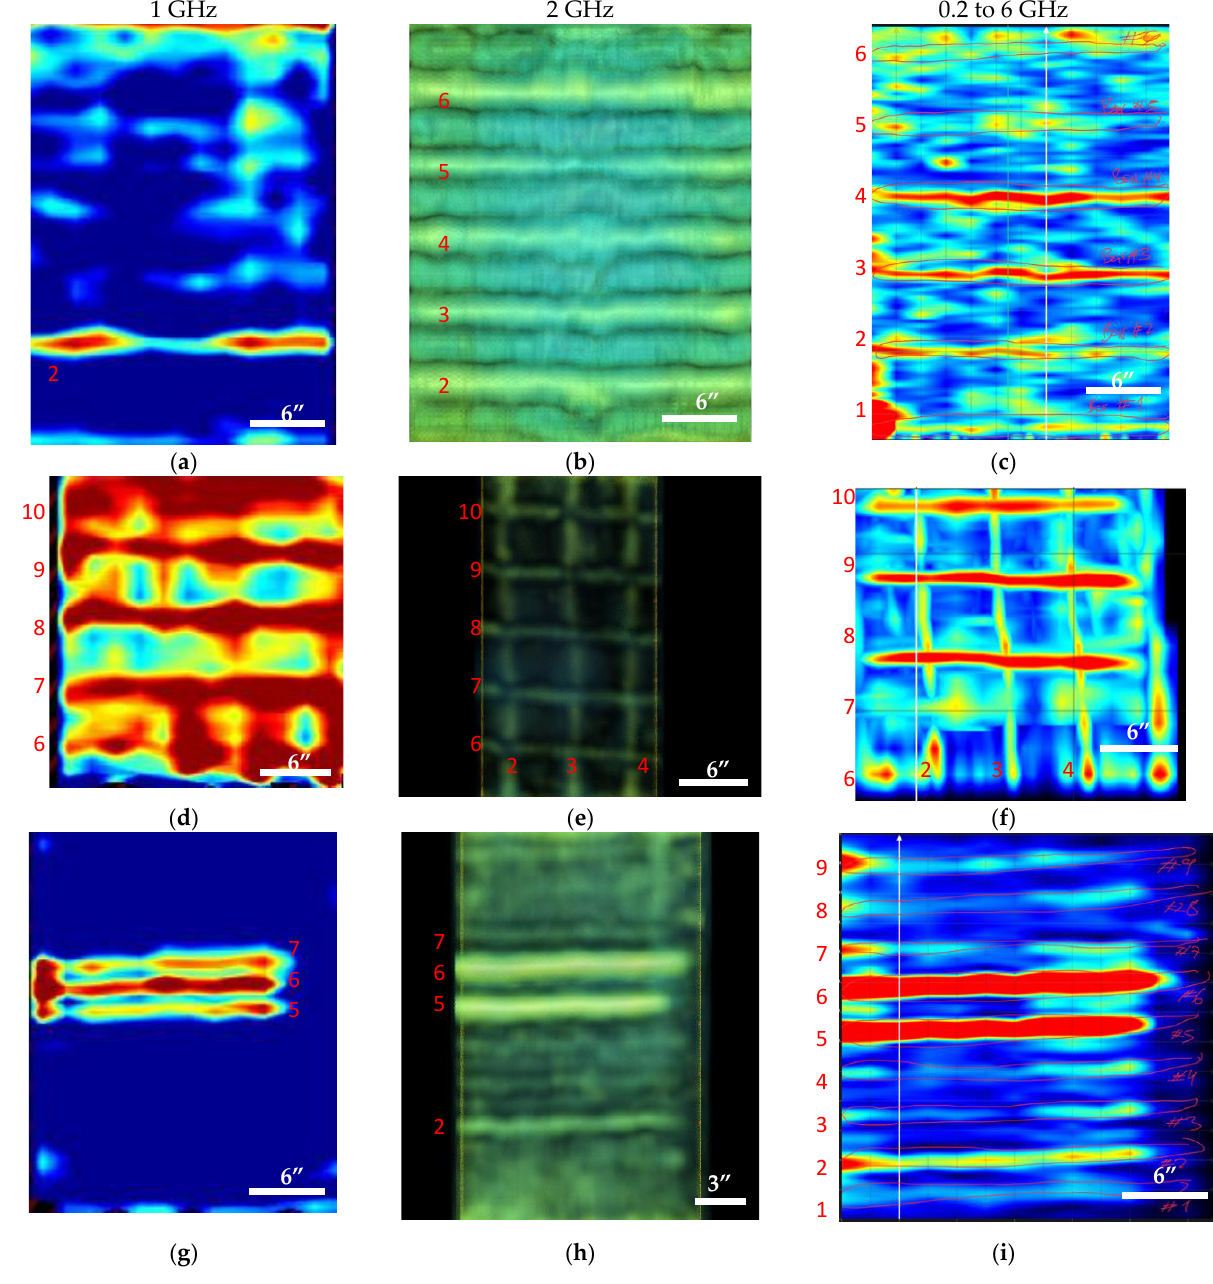
Figure 10. Depth slices: ( a ) Slab C using Conquest 100 Enhanced, ( b ) Slab C using C-Thrue, ( c ) Slab C using Proceq GP8800, ( d ) Slab J using Conquest 100 Enhanced, ( e ) Slab J using C-Thrue, ( f ) Slab J using Proceq GP8800, ( g ) Slab L using Conquest 100 Enhanced, ( h ) Slab L using C-Thrue, ( i ) Slab L using Proceq GP8000. In the case of depth slices for Slab J with a top and bottom mesh of GFRP bars, all the GPR devices could clearly detect the top mesh of #6 GFRP bars at a shallower depth, while the bottom mesh was only visible for the higher frequency GPRs, as shown in Figure 10d– f. The inability of lower frequency GPR to show the bottom mesh could be due to the same reason for not showing deeper GFRP bars in Slab C, as explained previously. In addition to the higher center frequency of the 2 GHz GPR device, its dual polarization feature fur- ther permits detection on both first and second levels of bars, whereas for the GPR device